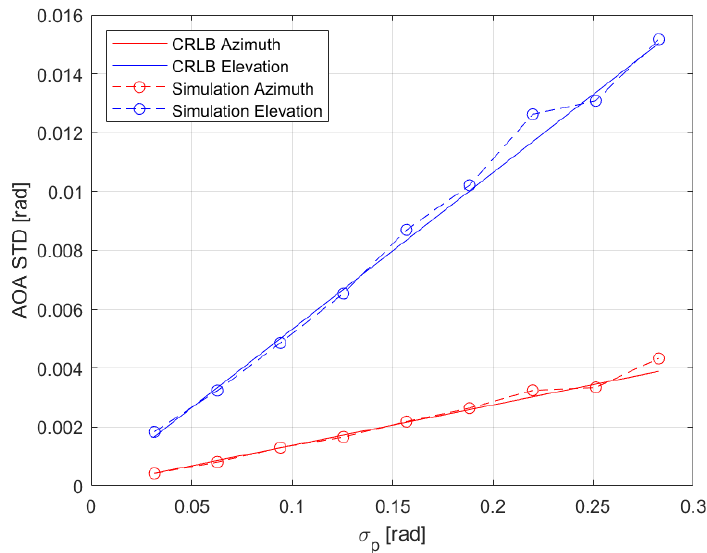
Figure 4. AOA standard deviation vs. phase errors standard deviation. Elevation is shown in blue, azimuth in red, CRLB in solid lines, and simulations in dashed lines with the circle marker.